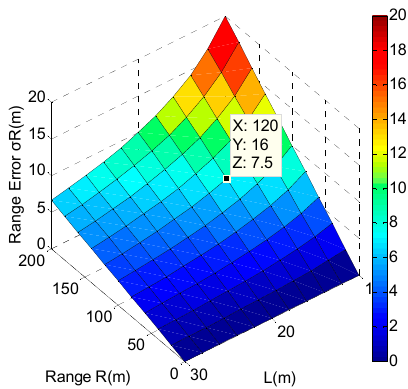
Figure 6. Distributions of the range error of L .